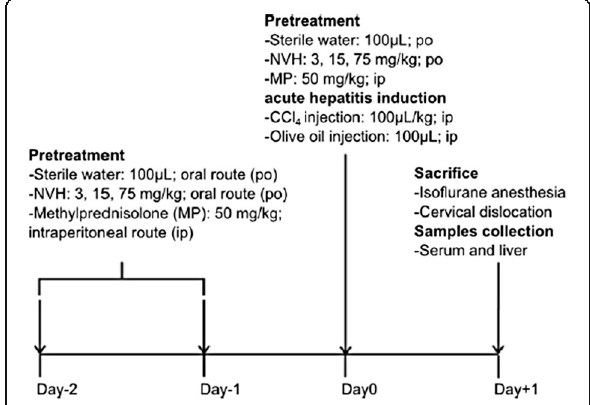
Fig. 1 Diagram CCl 4 -model experimental protocol